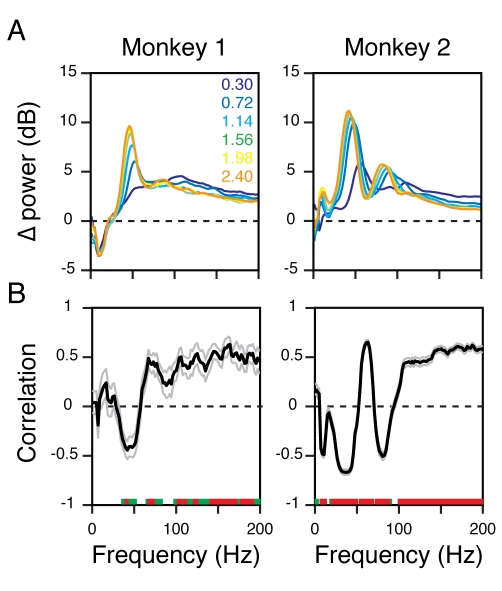
Correlations between power and firing rates have different signs in
gamma versus high-gamma bands.(A) Average relative change in power between 200 and 400 ms from baseline
power (difference between the colored traces and the black trace in
Figure 1F and
1I), for 15 and 104 sites in Monkeys 1 (left panel) and 2 (right
panel). Radii are listed again in the legend for clarity. (B) Spearman
rank correlation between the six power values (one for each size) at
each frequency and the six firing rates values, computed individually
for each site and then averaged. Black and gray traces show the mean and
SEM of 15 and 104 sites in the two monkeys. The correlation values
significantly different from zero are shown in green
(p<0.01, uncorrected) and red
(p<0.05 with Bonferroni correction).